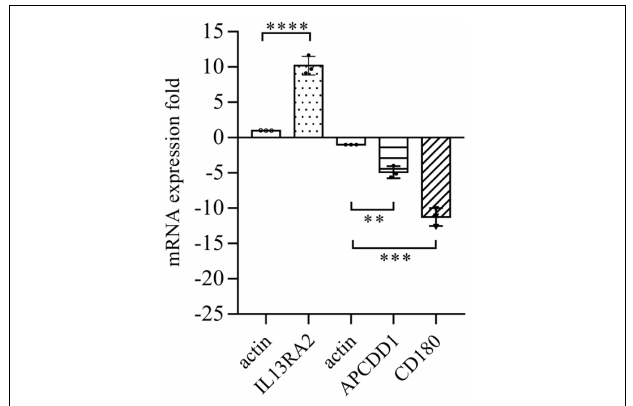
FIGURE 4 | Vitreous induced changes in the mRNA expression. The qPCR analysis of mRNA expression in ARPE-19 cells induced by vitreous. The mean ± SD of three independent experiments is shown; ∗∗∗∗ denotes 0.0001, using paired t test; ∗∗∗ denotes 0.001, using paired t test; ∗∗ denotes 0.01, using paired t test. Positive values indicate a fold increase in expression of the target gene relative to the internal reference, and negative values are opposite.